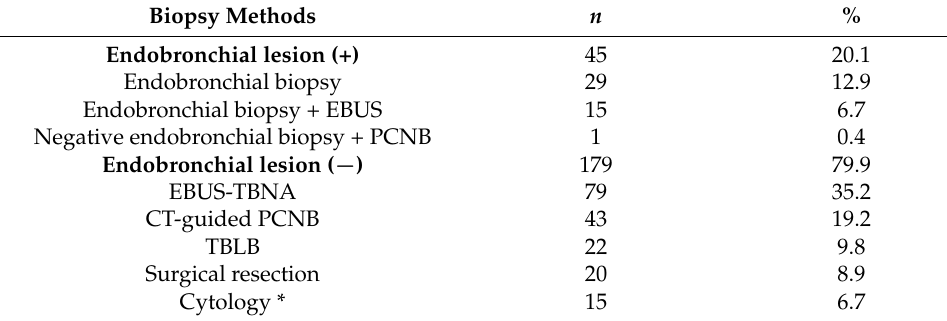
Table 2. Methods for tissue-based EGFR